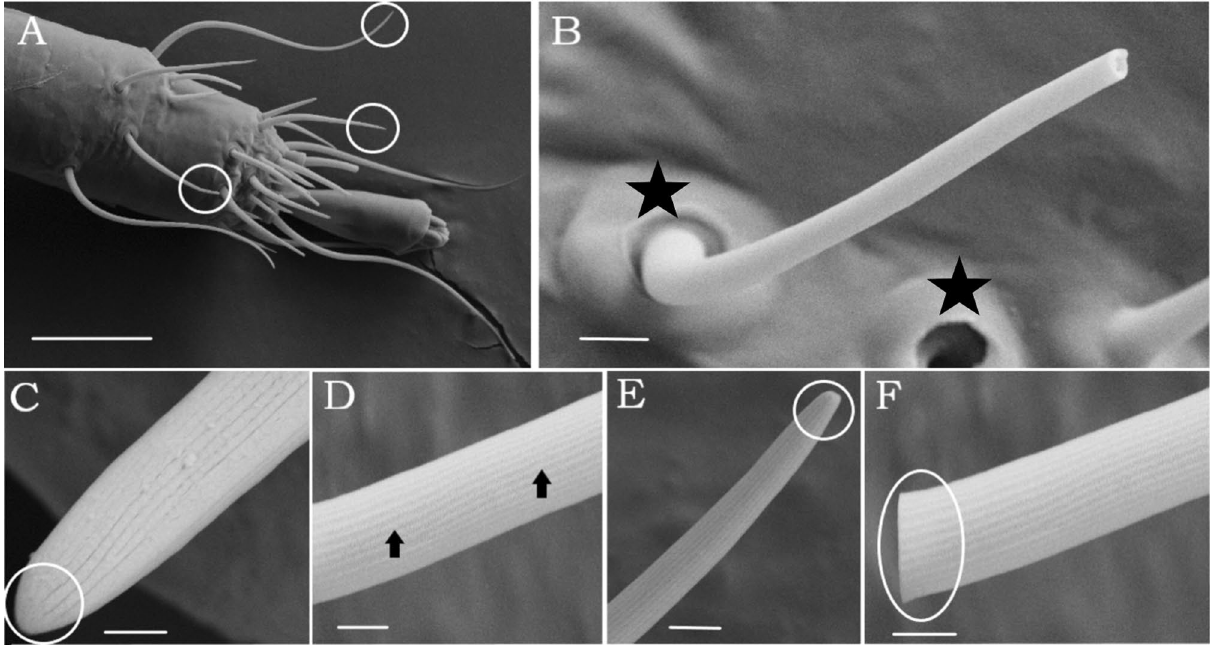
Figure 1. SEM of sensilla chaetica with or without tip-pore (Sc-tp). ( A ) Circles indicating sensilla chaetica with a tip pore or without pores on distalmost tarsomere of first leg. Different types of sensilla are not discriminated in this figure because of low magnifications. ( B ). Shaft broken in its apical part revealing a pore and structure of socket (white square) ( C ) No pore sensilla. ( D ) Lateral view of the Sc-tp displaying longitudinal grooves (arrows). ( E ) Tip-pore sensilla showed indistinct pore on tarsomere I (circle) F. Tip-pore sensilla showed visible tip pore on tarsomere III and delimited by a round margin (circle). Scale-bars : ( A ) 20 μm, ( B ) 2 μm, ( C ) 300 nm, ( D – F ), 1 μm.